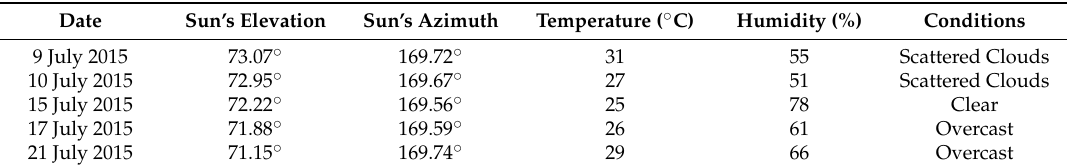
Table 2. The sun’s position recorded at the Beltsville Agricultural Experimental Station. Weather conditions recorded at the nearby College Park Airport weather station (KCGS) on the five days of experimentation, at experimentation start